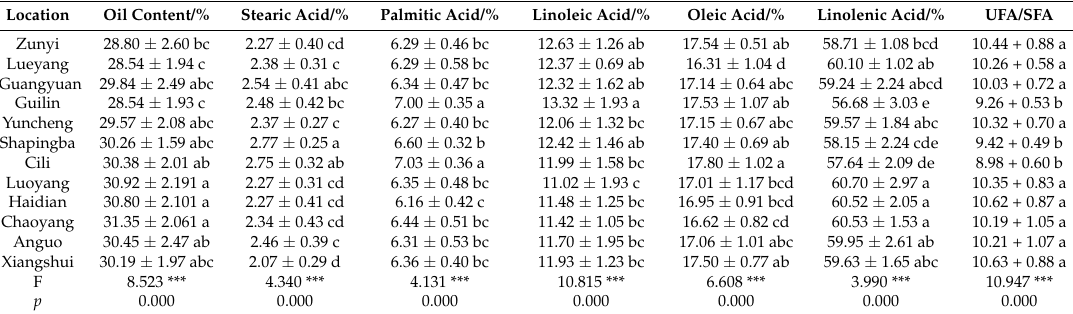
Table 2. Oil content and fatty acids composition of E. ulmoides seeds among 12 populations. Location Oil Content/% Stearic Acid/% Palmitic Acid/% Linoleic Acid/% Oleic Acid/% Linolenic Acid/% UFA/SFA Zunyi 28.80 ± 2.60 bc 2.27 ± 0.40 cd